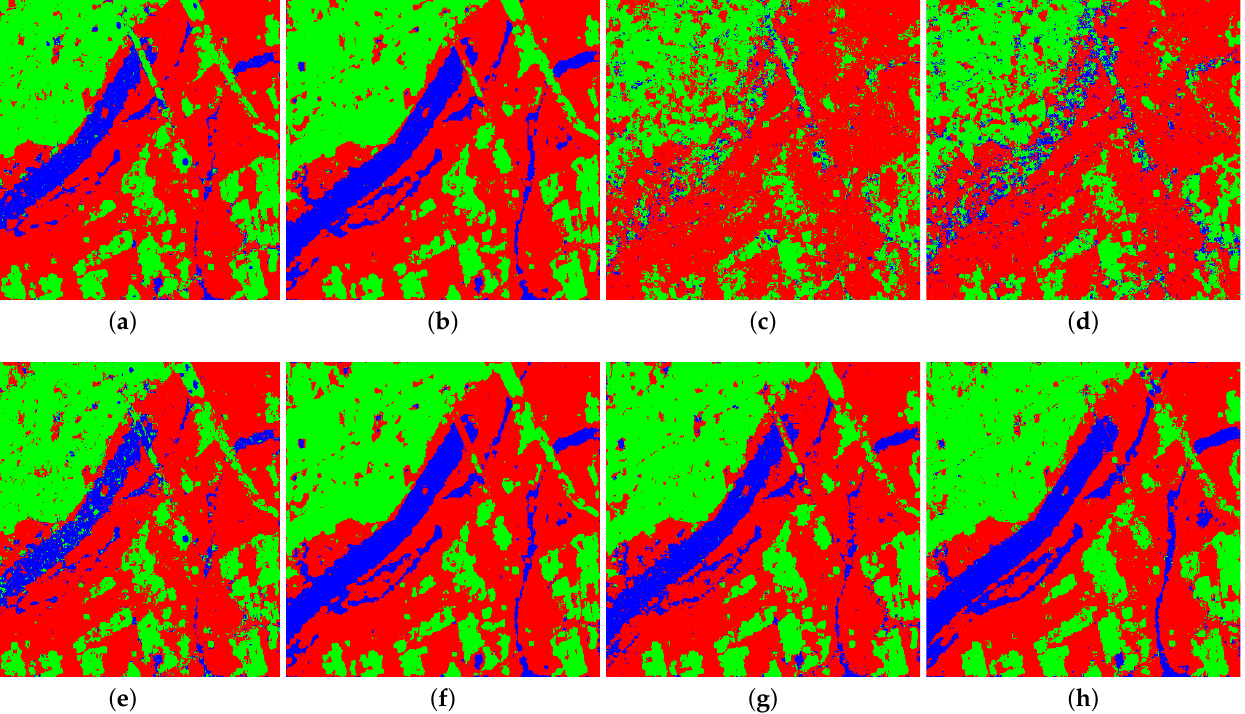
Figure 6. Prediction result of Xi’an area obtained by four classifiers on different forms of Touzi decomposition parameters, including ( a ) SVM on original parameters, ( b ) SVM on normalized parameters, ( c ) ANN on original parameters, ( d ) ANN on normalized parameters, ( e ) AE on original parameters, ( f ) AE on normalized parameters, ( g ) AEFT on original parameters, and ( h ) AEFT on normalized